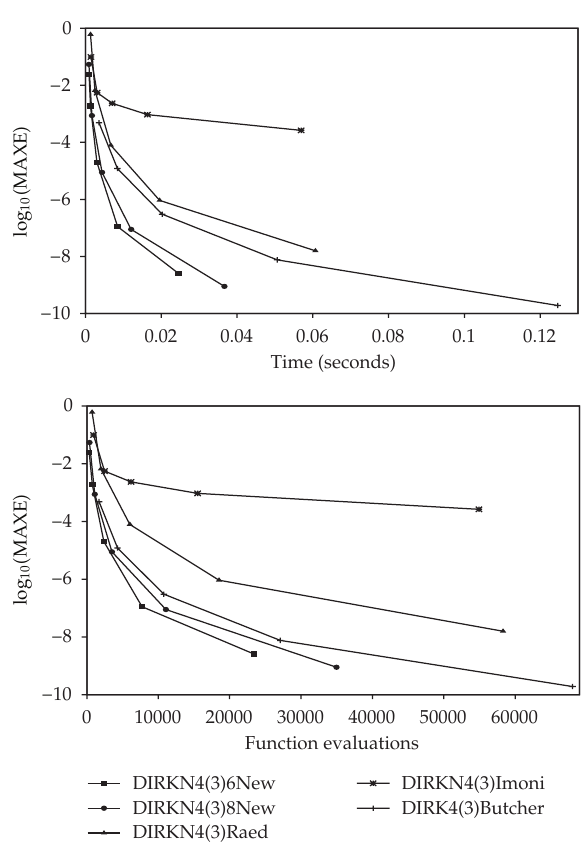
Figure 2: E ffi ciency curves for Problem